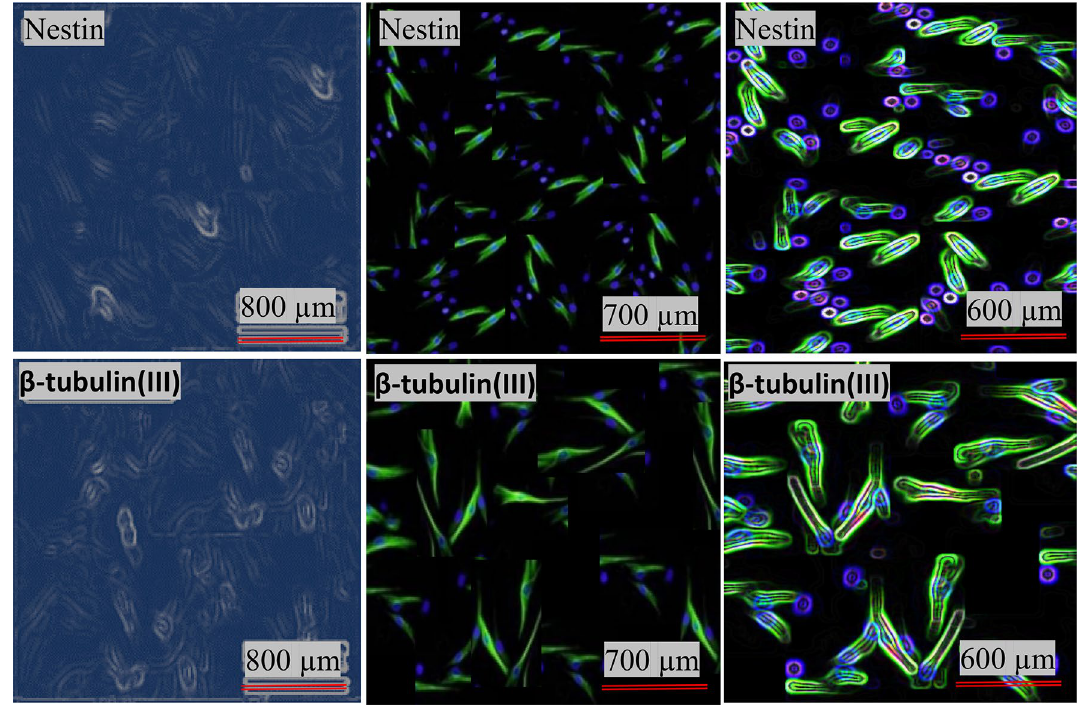
Figure 2. Photographic and fluorescence images of differentiated neuron cells stained with DAPI. Insets: high- resolution images.